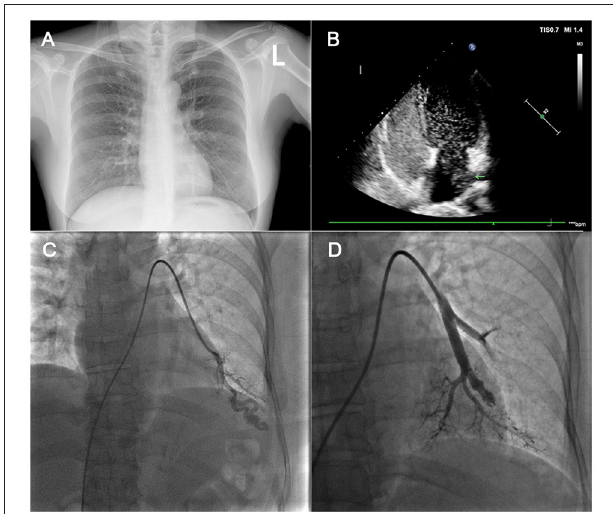
FIGURE 2 | In (A) : this patient had a chest X-ray with no abnormalities. In (B) , the four-chamber image of CTTE showed markedly positive result and left chamber microbubbles came from the left lower pulmonary vein. In (C) , a left lower lobe PAVM was noted on pre-treatment DSPA image. In (D) , the PAVM was embolized. TTCE, transthoracic contrast echocardiography; DSPA, digital subtraction pulmonary angiography; PAVM, pulmonary arteriovenous